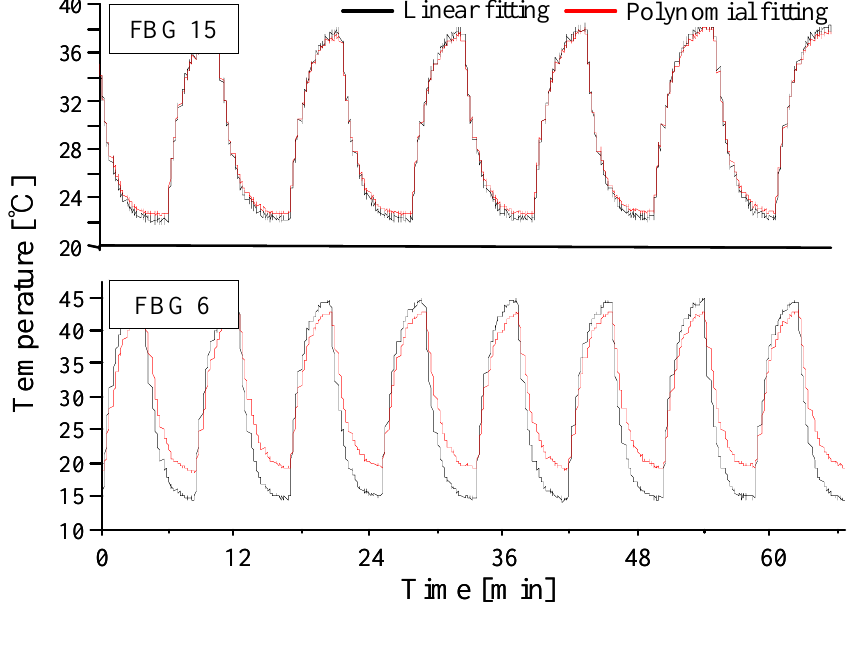
Figure6. Temperature measurements with a temperature modulator